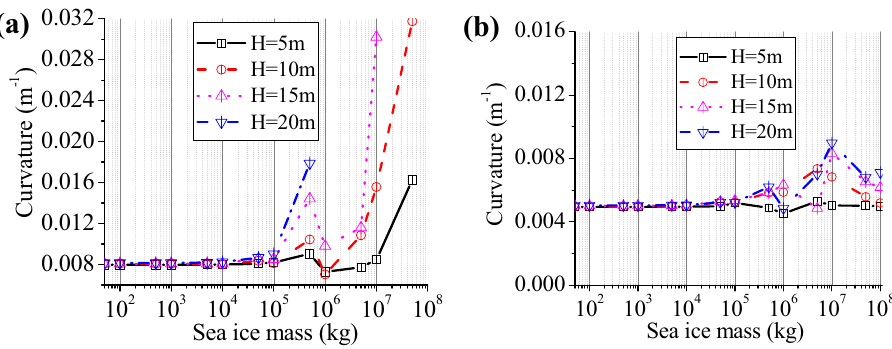
Figure 4. Highest curvature of the structural bottom at various water depths: ( a ) T1-II-1; ( b )